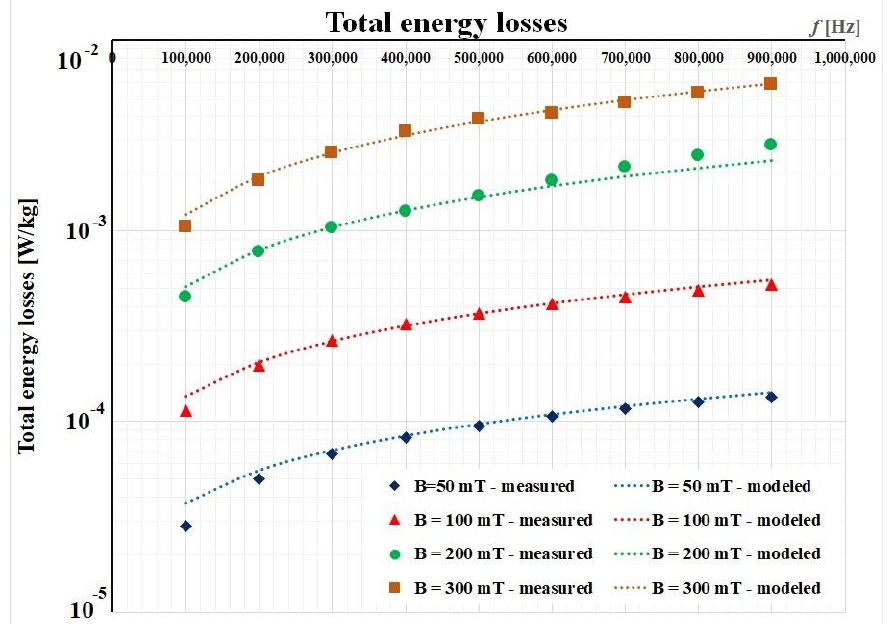
Figure 7. Initial fitting procedure for the FINEMET ribbon.